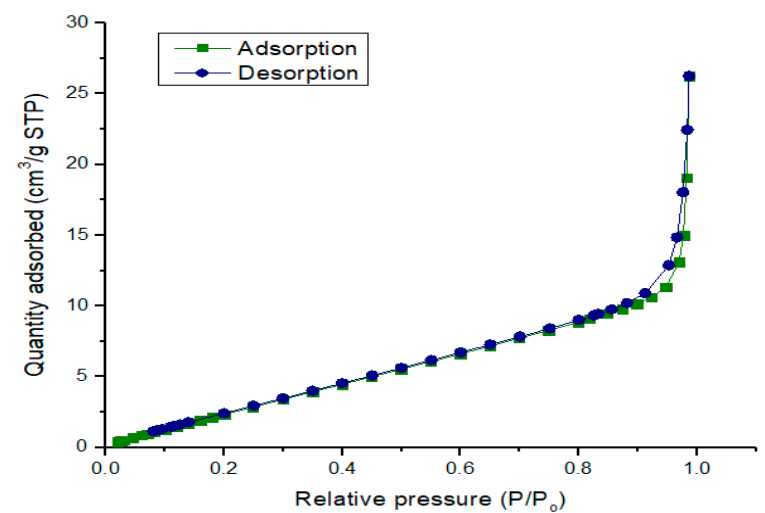
Figure 5. Plot of physisorption isotherms against relative pressure.